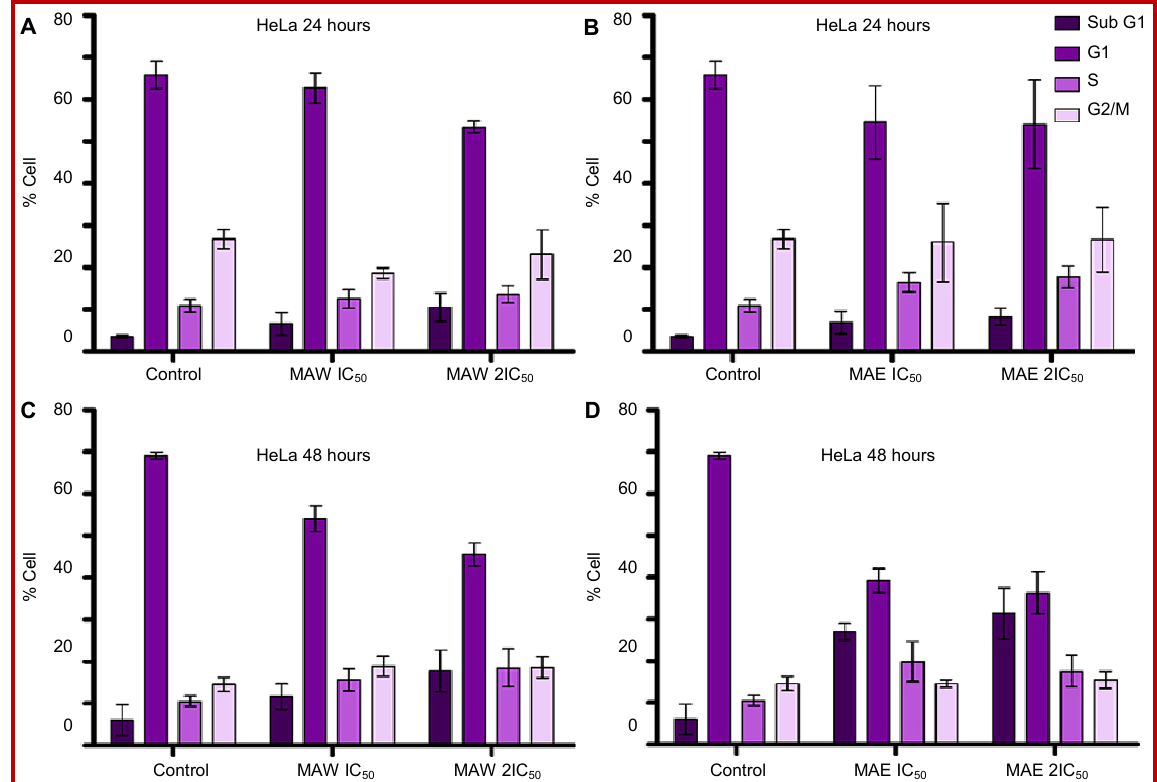
Figure 2: Changes in the cell cycle phase distribution of HeLa cells induced by M. aquifolium extracts after 24 (A, B) and 48 hours (C, D) of treatment